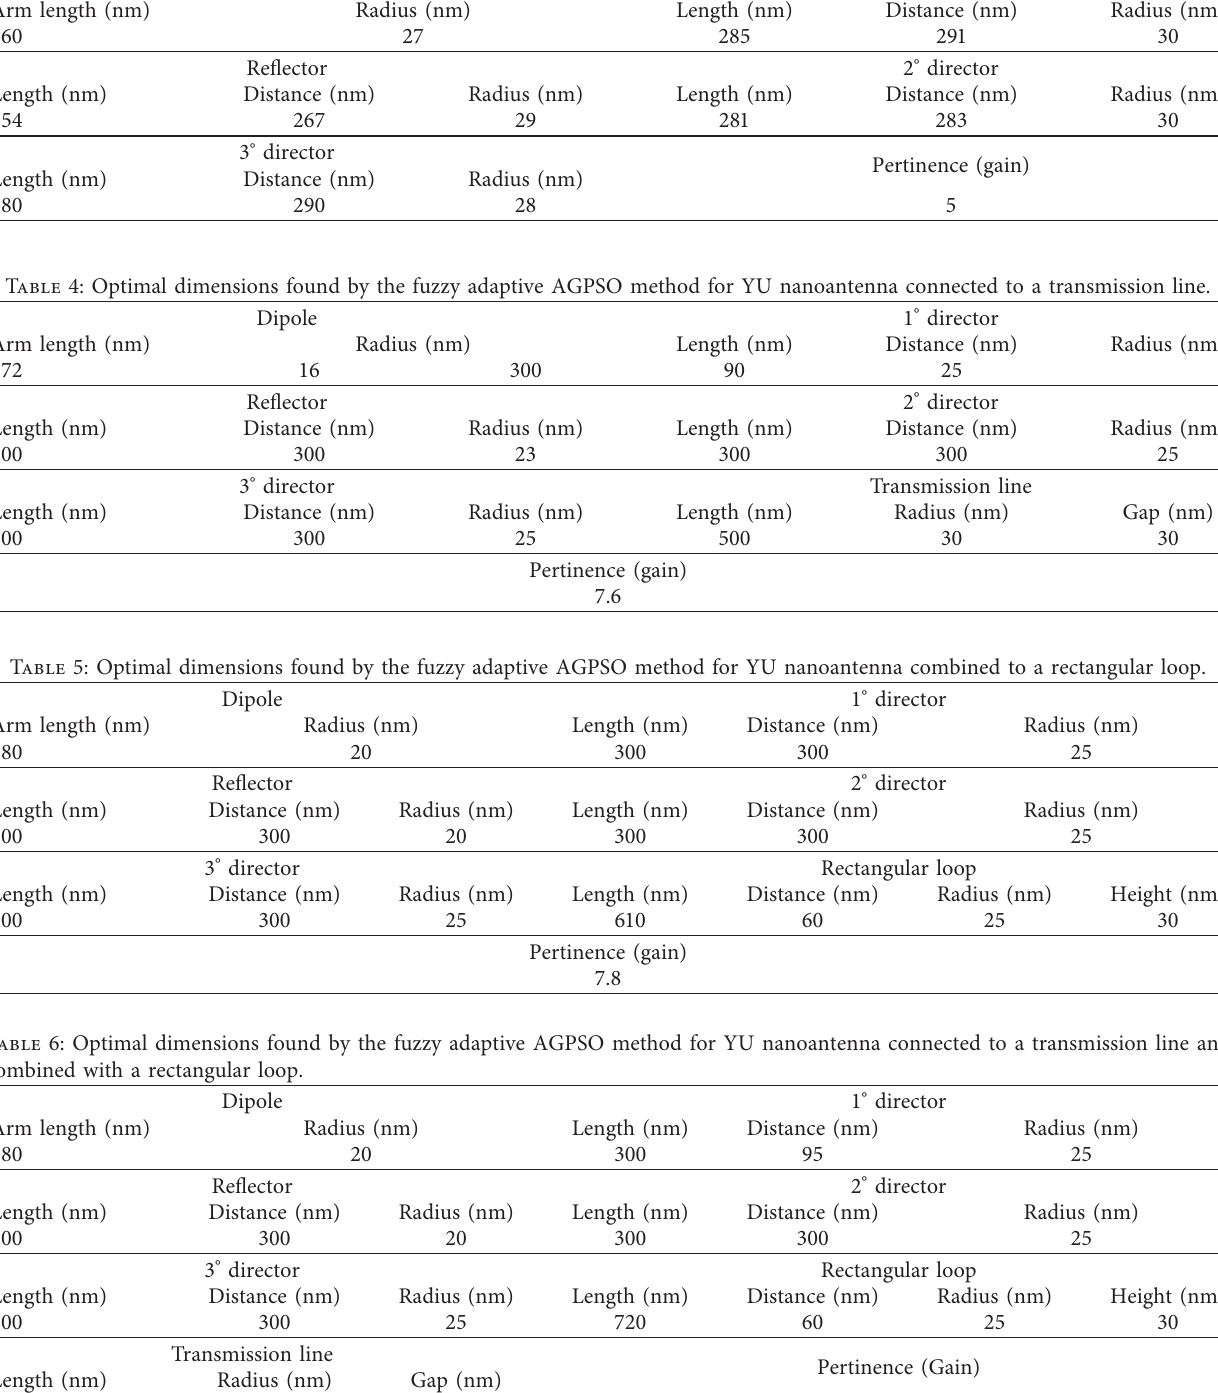
Table 3: Optimal dimensions found by fuzzy adaptive AGPSO method for conventional YU nanoantenna. Dipole